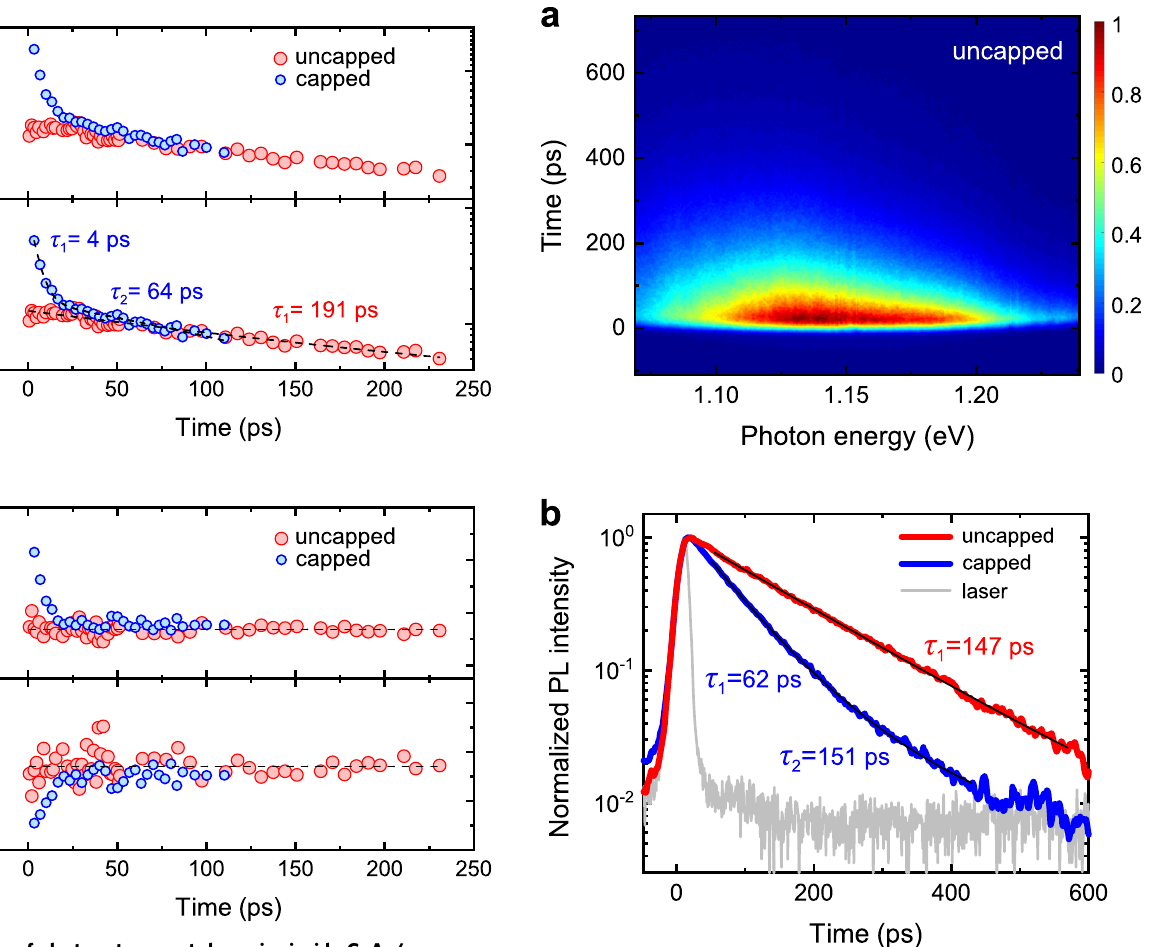
Fig. 4 Analysis of electron transport dynamics inside GaAs/ In 0.37 Al 0.63 As (uncapped) and GaAs/In 0.43 Al 0.57 As/In 0.44 Ga 0.56 As (capped) nanowires based on optical-pump THz-probe spectroscopy measurements at room temperature. a Temporal evolution of plasmon frequency ω 0 (top) and the associated electron density n (bottom). The dashed lines are mono-exponential and bi-exponential fi ts for the uncapped and capped nanowires, respectively. b Temporal evolution of momentum scattering rate γ (top) and the associated mobility μ e (bottom) of electrons. The dashed lines are linear fi ts for the uncapped nanowires.